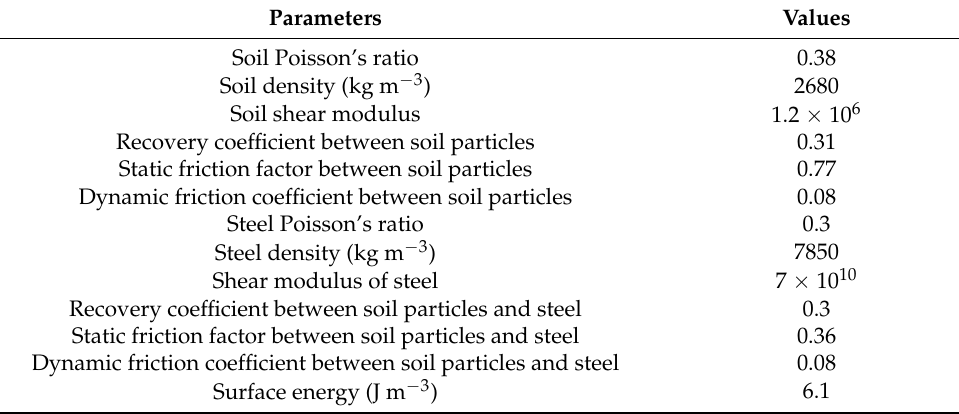
Figure 5. ( a , b ) Angle of repose experiment of soil. Table 1. Soil parameters for simulation.